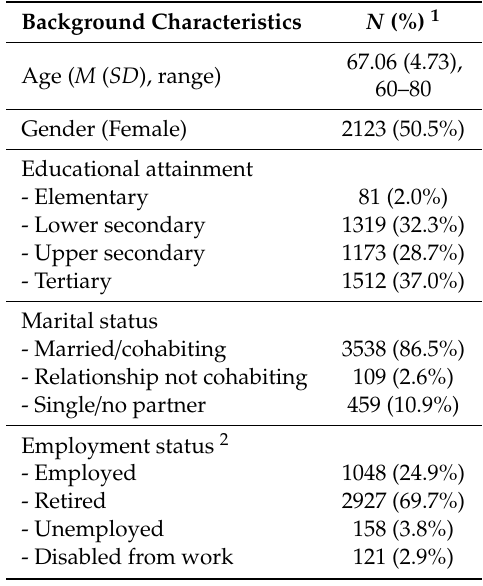
Table 1. Sample background characteristics ( N =